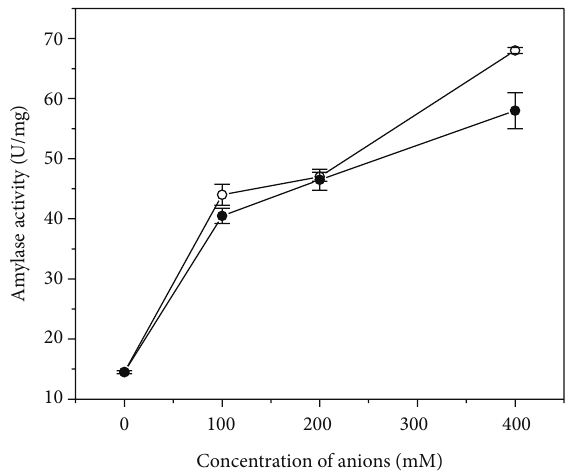
Figure 5: Effect of anions (nitrate and chloride ions) on amylase production after 48 hours of SSF, ( I ): specific activity of 𝛼 -amylase in presence of nitrate ion from SSF extract; ( e ): specific activity of 𝛼 -amylase in presence of chloride ion from SSF